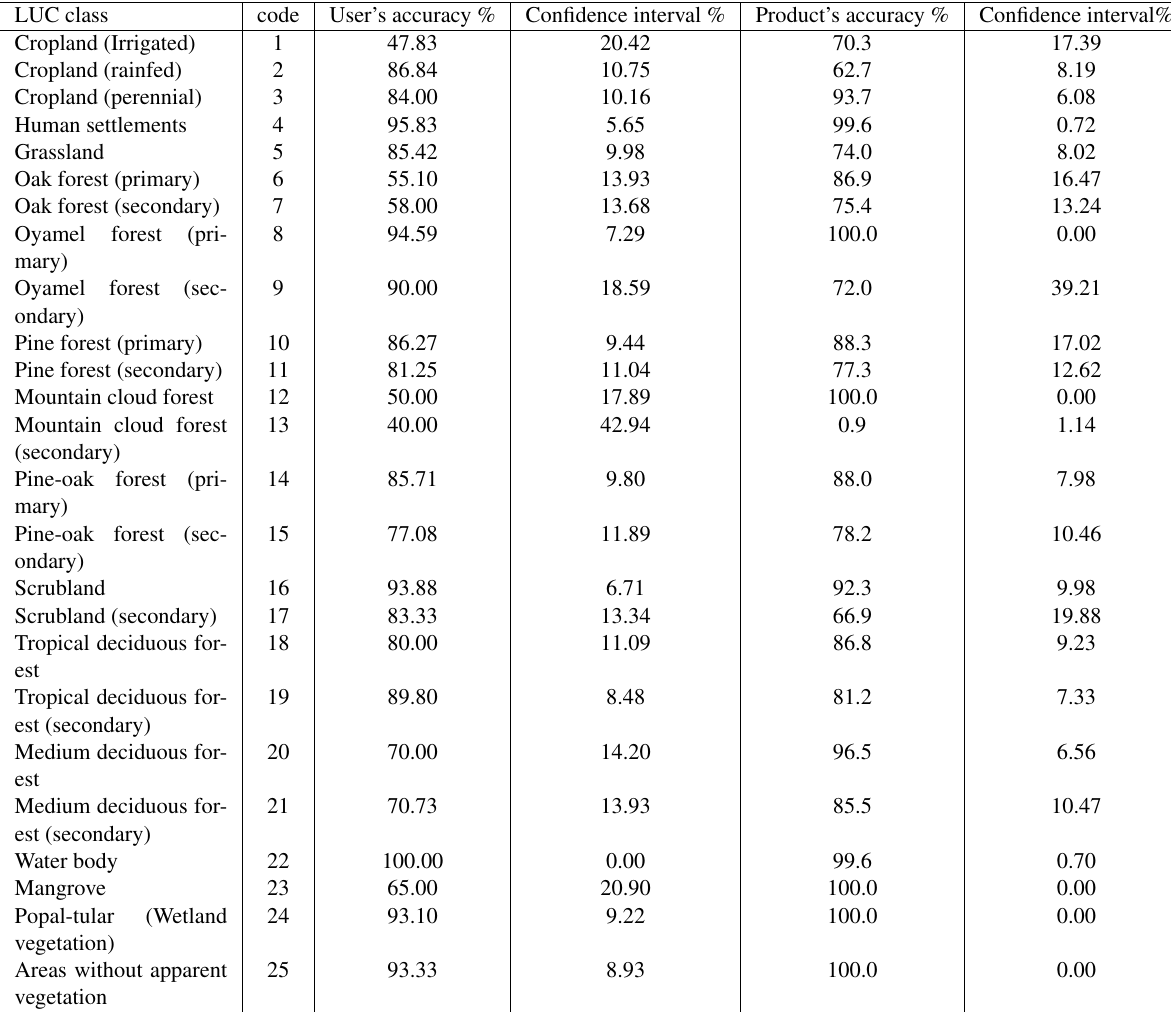
Table 2: User’s and Product’s accuracies along with their confi- dence